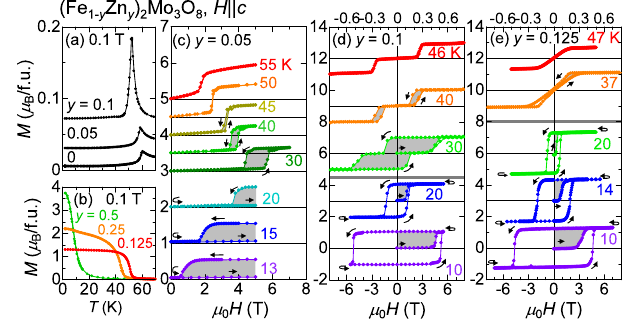
FIG. 4. (a, b) T and (c – e) H dependence of M for ð Fe Þ Þ Zn 1 − y Zn y 2 Mo 3 O 8 with various values of y under H 2 Mo 3 O 8 y y Each scan starts after cooling to the target T without a field. The horizontal scale of μ 0 H for data above the gray horizontal bars in (d) and (e) is appended at the top of each panel. Data for (a) and (c – e) are shifted for